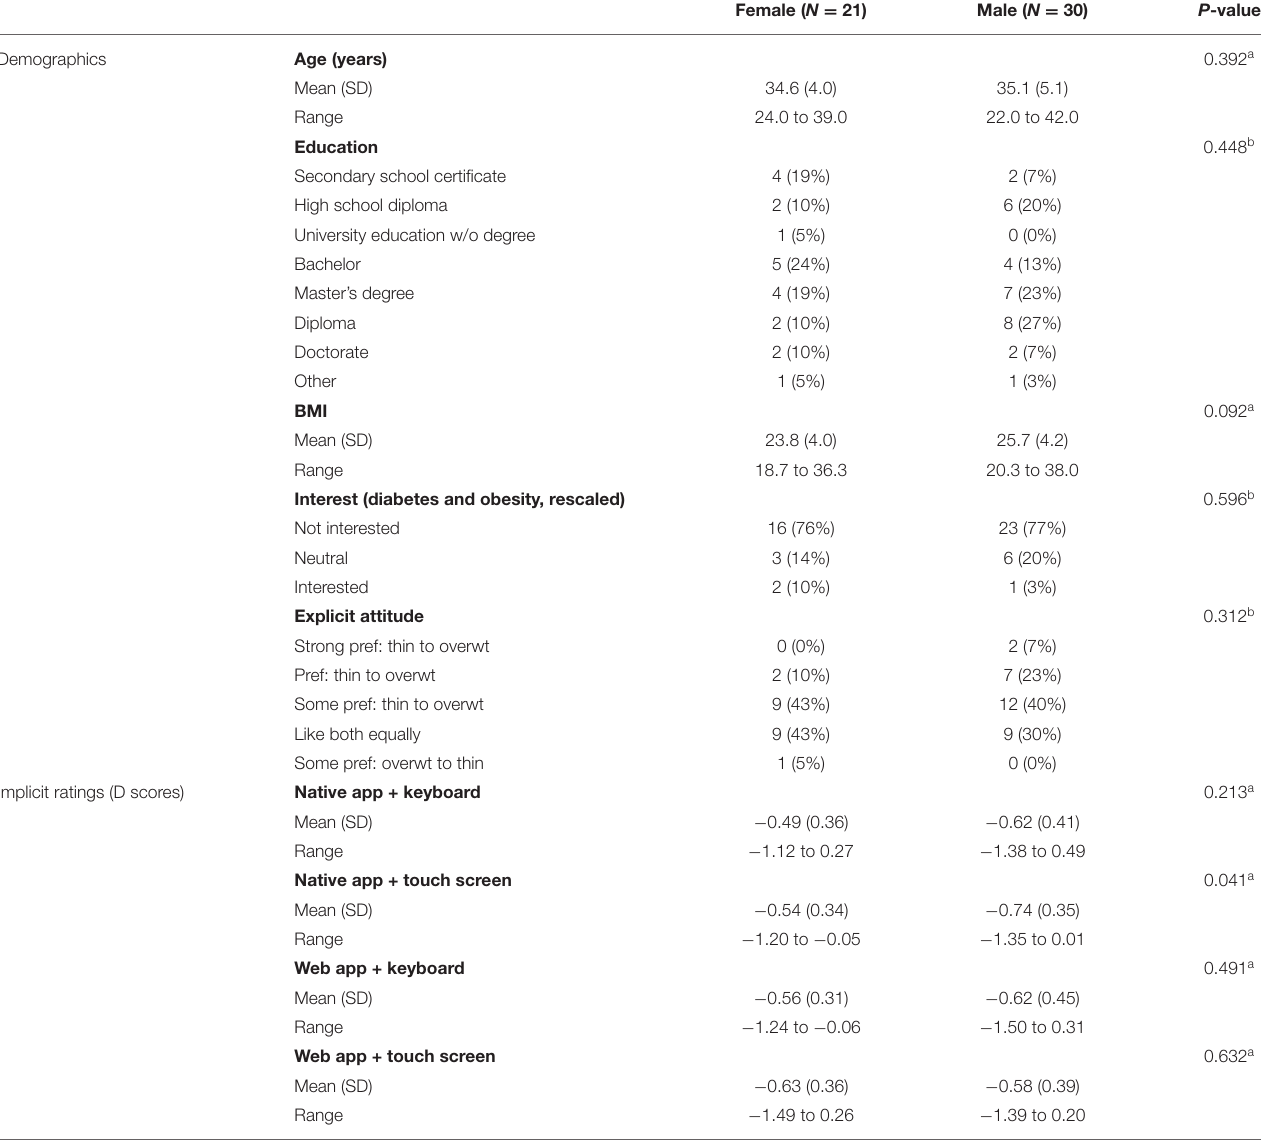
TABLE 2 | Gender specific differences regarding overall demographics as well as D scores (representing implicit ratings) for the four test